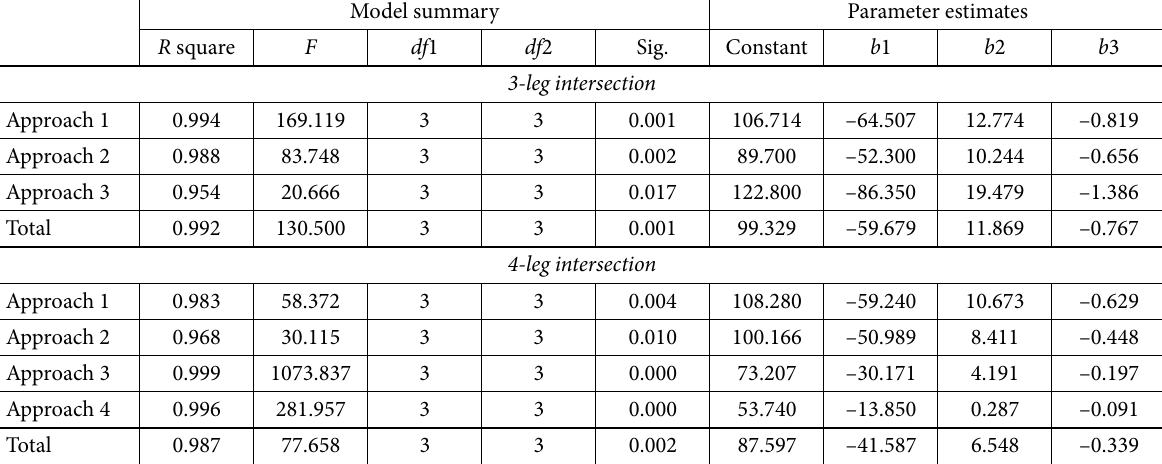
Table 10. Matching of RLR second after red-light onset with Cubic distribution for the approaches and for the intersection overall Model